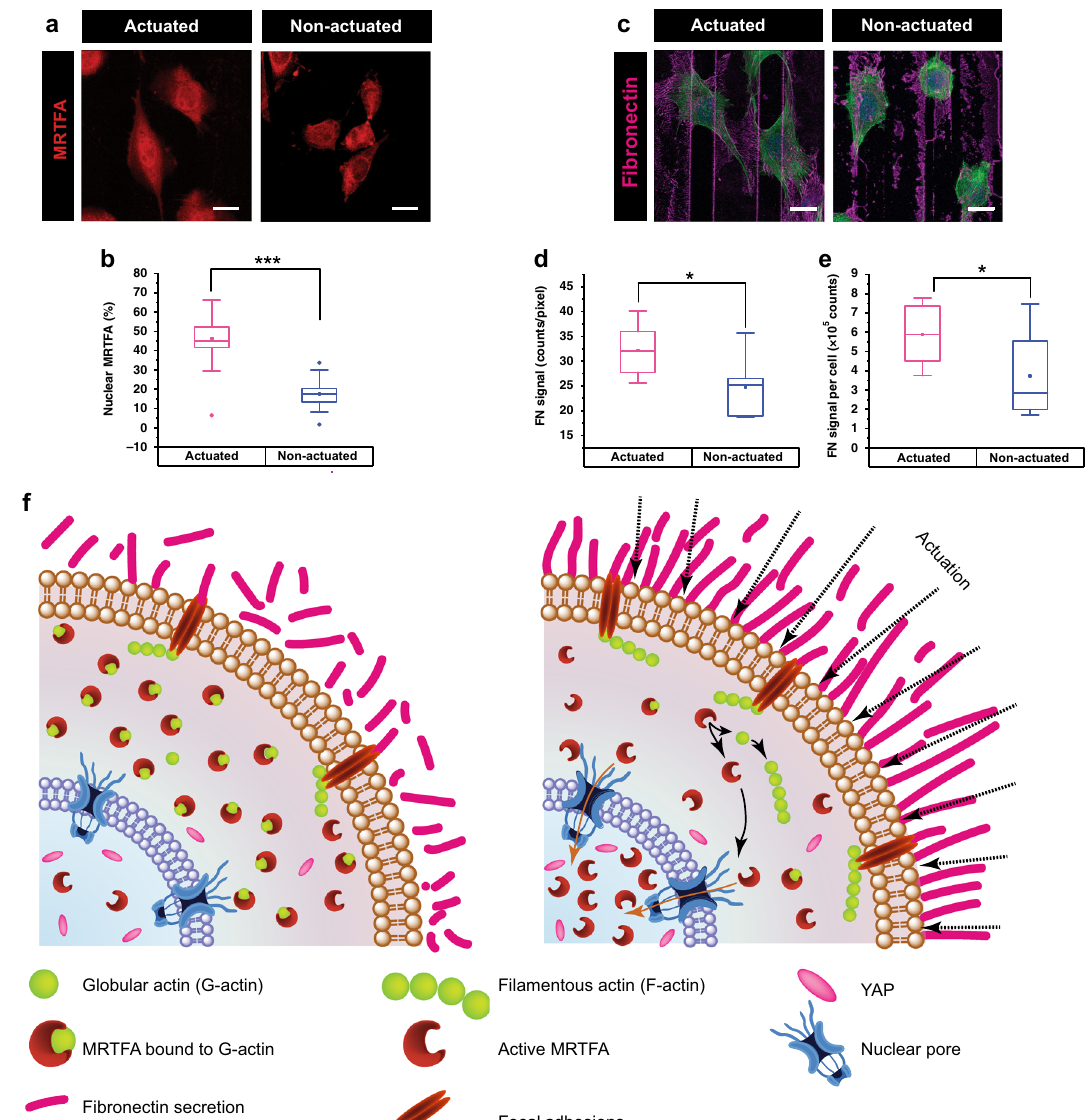
Fig. 5 The effect of actuation on mechanosensitive proteins MRTFA and YAP, and the suggested mechanism. a Immuno fl uorescent images of MRTFA stained cells grown on collagen I coated gels (60/40 % NIPAM/NEAM gel with AuNRs) that are present in the actuating area (340 mW power, 1 Hz, 100 ms laser ON time, top row) showing nuclear localisation and in the non-actuating area where MRTFA is in the cytoplasm, b Quanti fi cation of the nuclear percentage of MRTFA ( n = 3, N ≥ 60 cells). c Immuno fl uorescent images of cells grown on collagen I coated gels shows more aligned fi bronectin secretion when cells are actuated, n = 3, N ≥ 211 cells) (green = actin, blue = nucleus, scale bar = 20 µ m). d , e Quanti fi cation of the fi bronectin signal shows more fi bronectin in the actuated region as well as more fi bronectin production per cell by actuated cells. f A schematic depicting the suggested mechanism. When the hydrogel fi lm actuates, cells experience forces that are transduced to the nucleus via F-actin fi laments, formed by G-actin polymerisation. When G-actin is released to make F-actin, MRTFA translocates from the cytoplasm to the nucleus. Upon cessation of actuation, MRTFA returns back to the cytoplasm. YAP, on the other hand, does not show shuttling behaviour in response to actuation of this hydrogel fi lm but is already present in the nucleus due to the stiffness of this gel (~30 kPa under cell culture conditions). In the box plots, the interquartile range (IQR) between the fi rst and the third quartiles is indicated by the box, while whiskers denote 1.5 IQR. The hollow square, the horizontal line, and the fi lled dots represent the average, the median, and the outliers, respectively. *, **, *** are determined using one way ANOVA or Welch test, depending on the homogeneity of variances, and represent statistical signi fi cance at p < 0.05, 0.01 and 0.001,